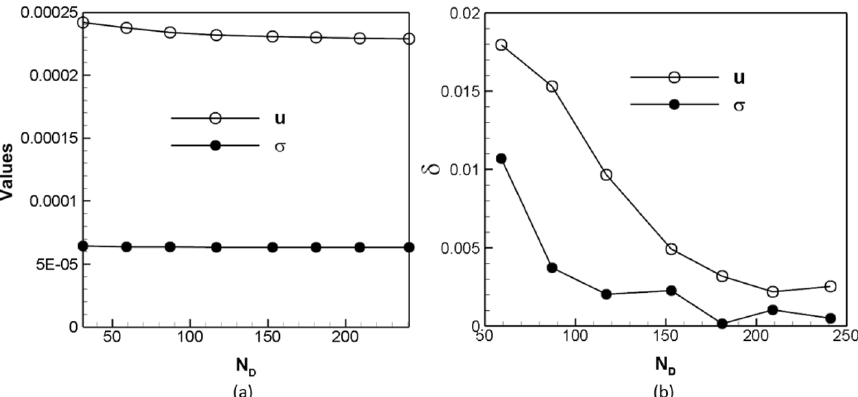
Figure 6. Convergence checks for determining appropriate spatial resolution: (a) Spatial mean velocity u (empty circle) and shear stress σ (solid circle) and (b) relative differences of u and σ between two successive resolutions (δ) versus the cell number along the diameter ( N D ).